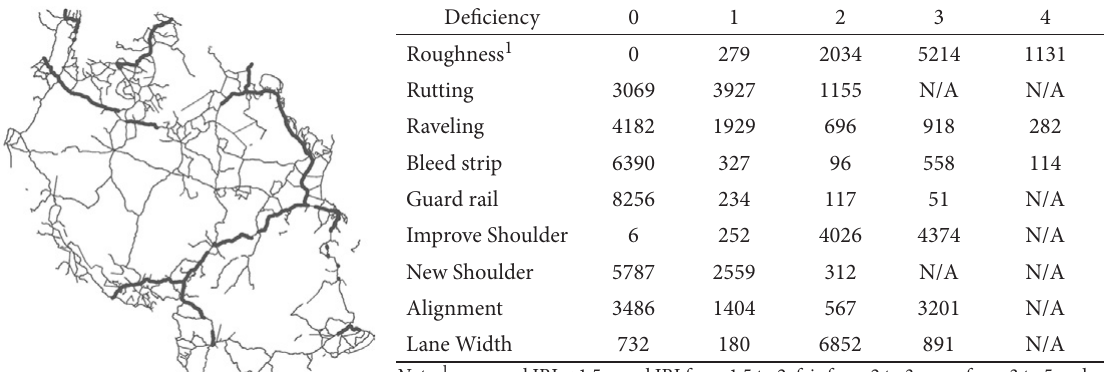
fig. 1. Tanzania Road Network and Inventory of deficiencies (segment